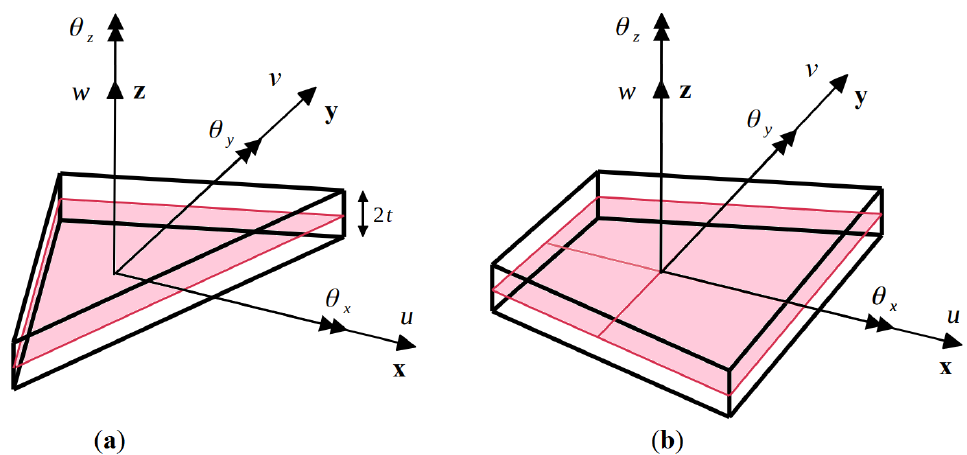
Figure 1. Sign conventions for the kinematic variables of the two inverse elements: ( a ) three-node triangular element, iMIN3; and ( b ) four-node quadrilateral element, iQS4.